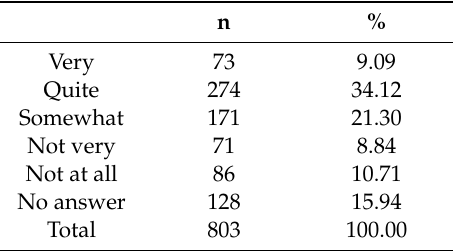
Table 3. Satisfaction with aquaculture fish.